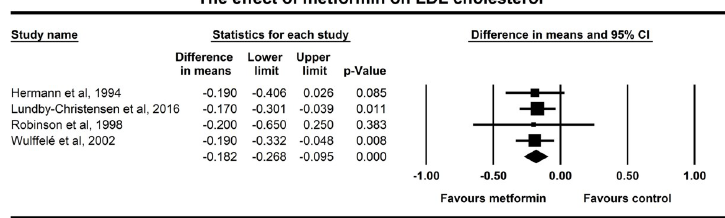
Fig 6. Forest plot analysis of LDL cholesterol in participants treated with metformin compared with placebo. The other outcome parameters reported by the six articles, i.e. changes of HDL (p = 0.648),